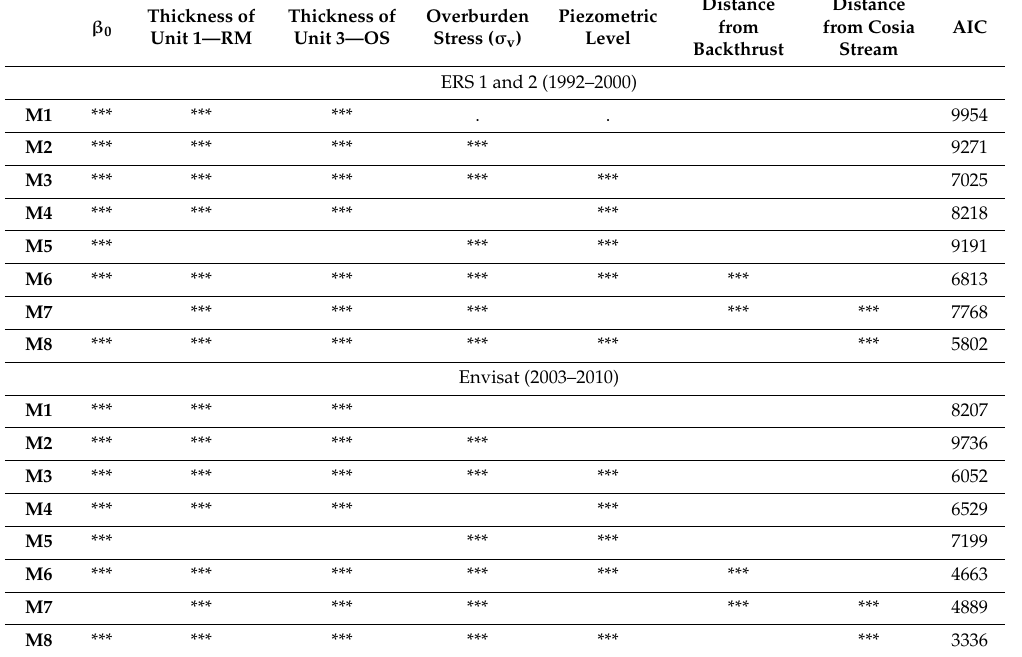
Table A3. Summary of all tested nonlinear regression models (M) using generalized additive model (GAM). β 0 is the parametric component of the predictors (see Equations (3) and (4)). Here, only the Akaike Information Criterion (AIC) is computed. Significance codes of p -values: *** = 0; . =